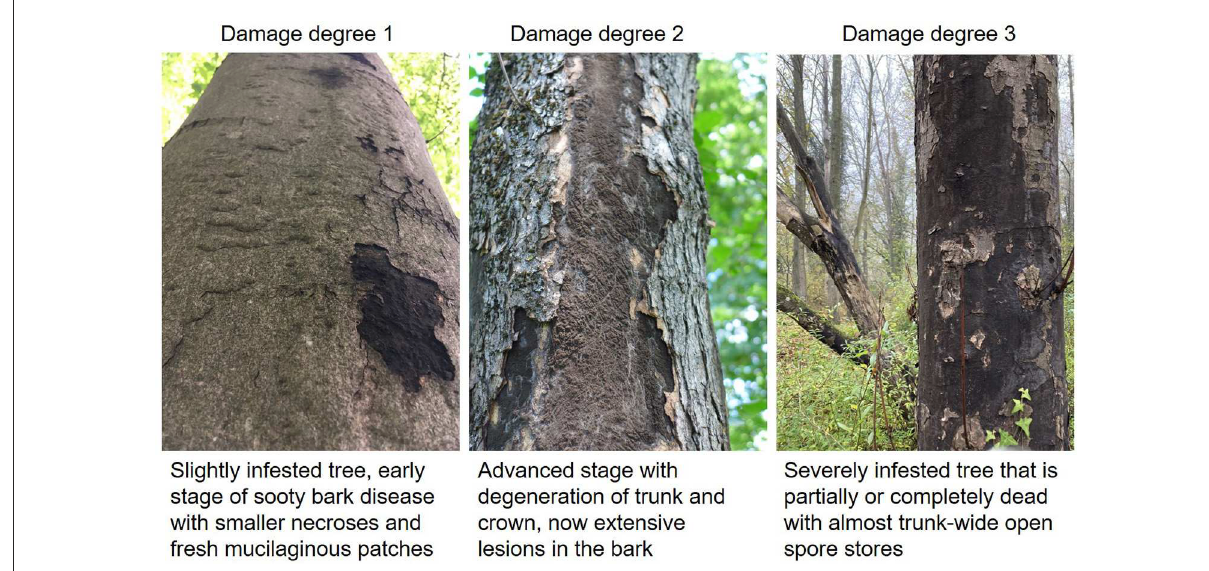
FIGURE2 Different degrees of damage by sooty bark disease ( C. corticale ) on sycamore maple.